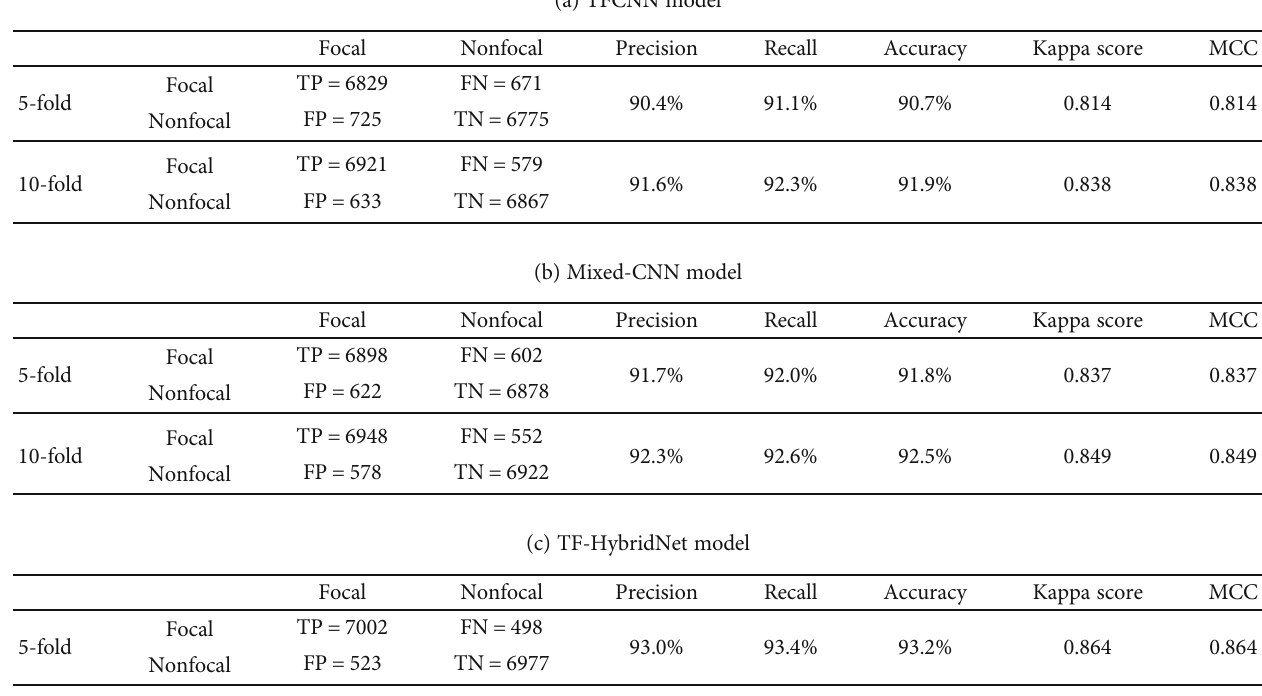
Table 1: Confusion matrices and performance measures of the proposed